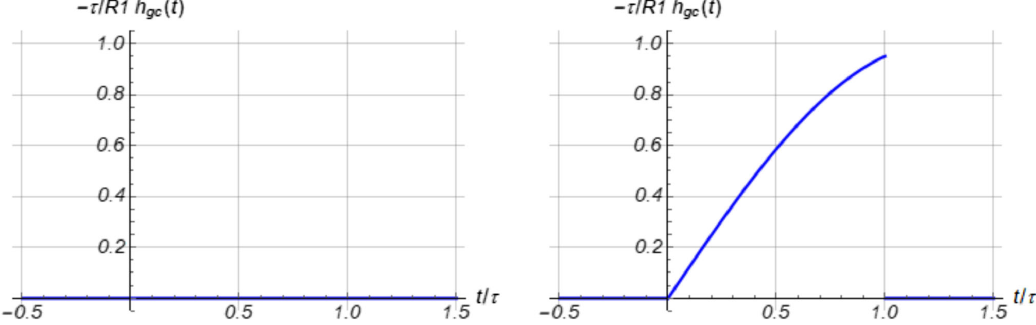
t Þ normalized. For Δ f 0 τ ¼ 0 (left) and Δ f 0 τ ¼ 0 . 2 (right). gc ð